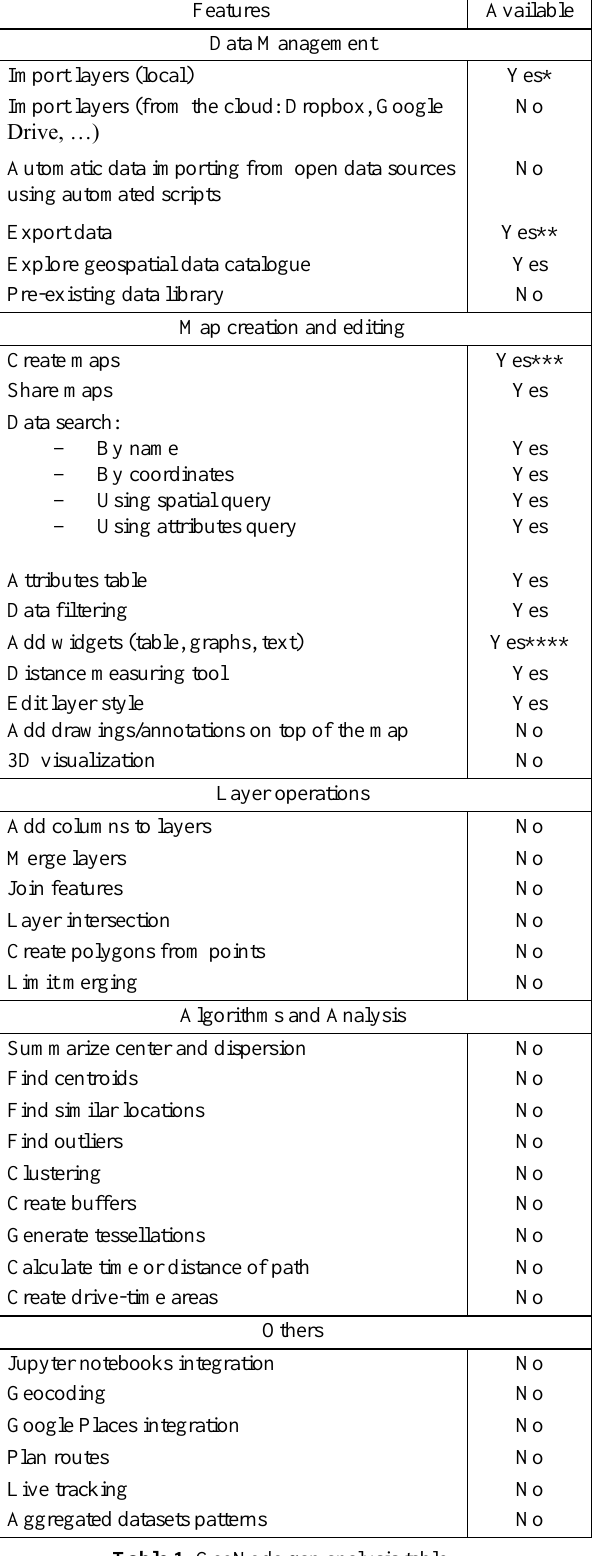
Table 1 . GeoNode gap analysis table.